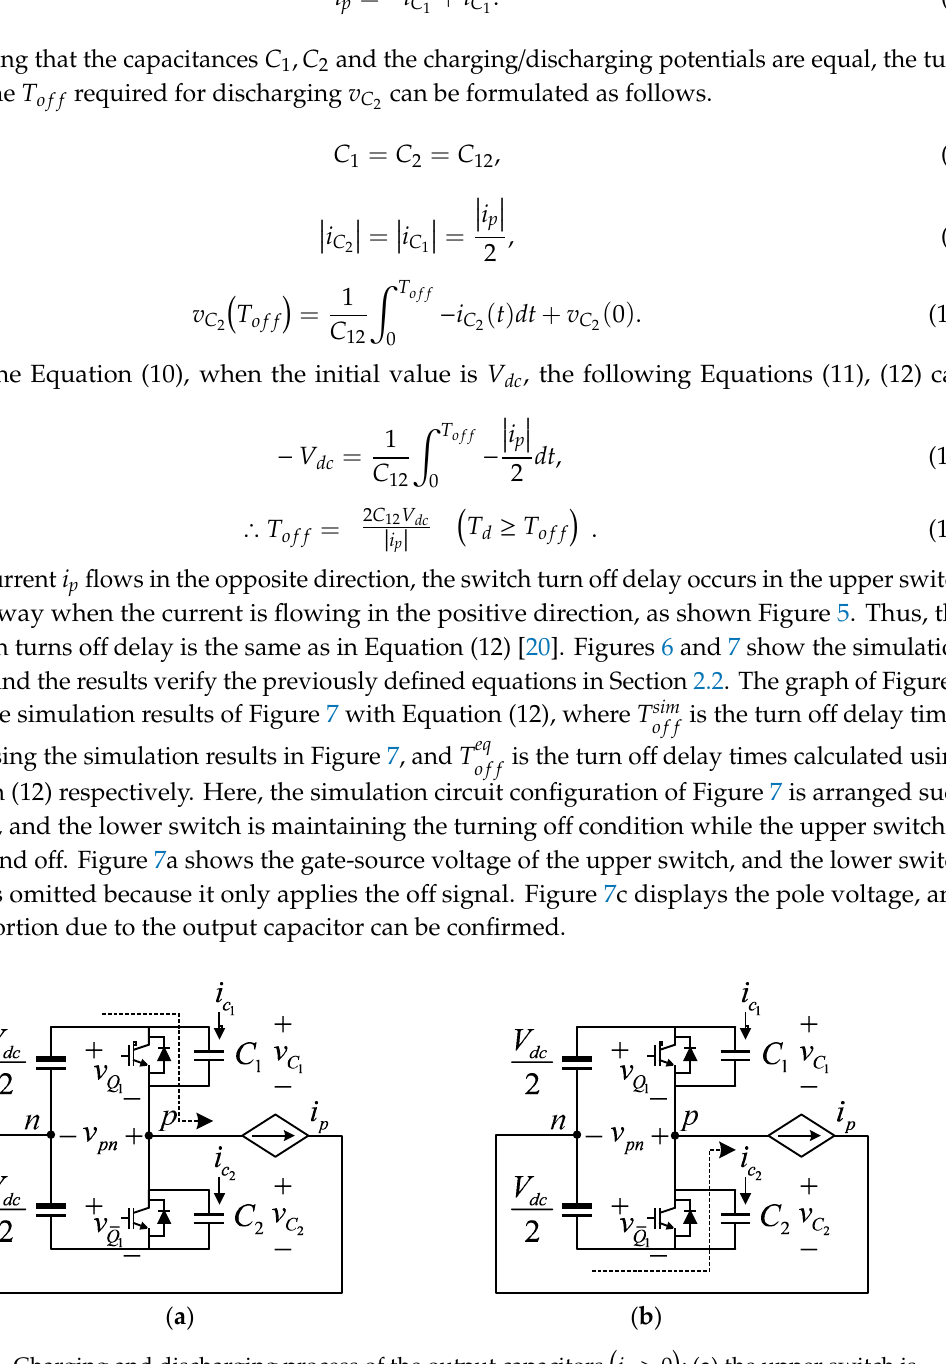
Figure 5. Charging and discharging process of the output capacitors turning on; ( b ) the upper switch is turning o ff